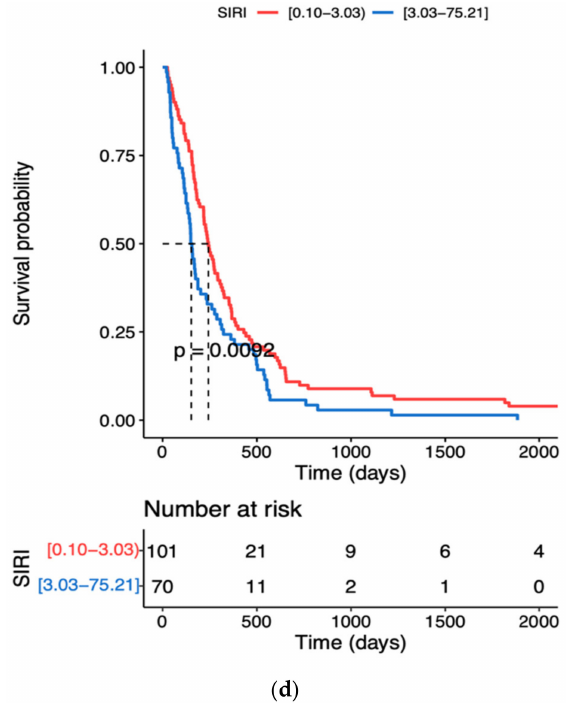
Figure 1. Kaplan–Meier survival curves during hospitalisation of GBM patients with different cut-off values of the age and systemic inflammation markers: ( a ) Age, ( b ) NLR neutrophil to lymphocyte ratio, ( c ) SII systemic immune inflammation index, ( d ) SIRI systemic inflammation response index; the dotted line designates median survival.